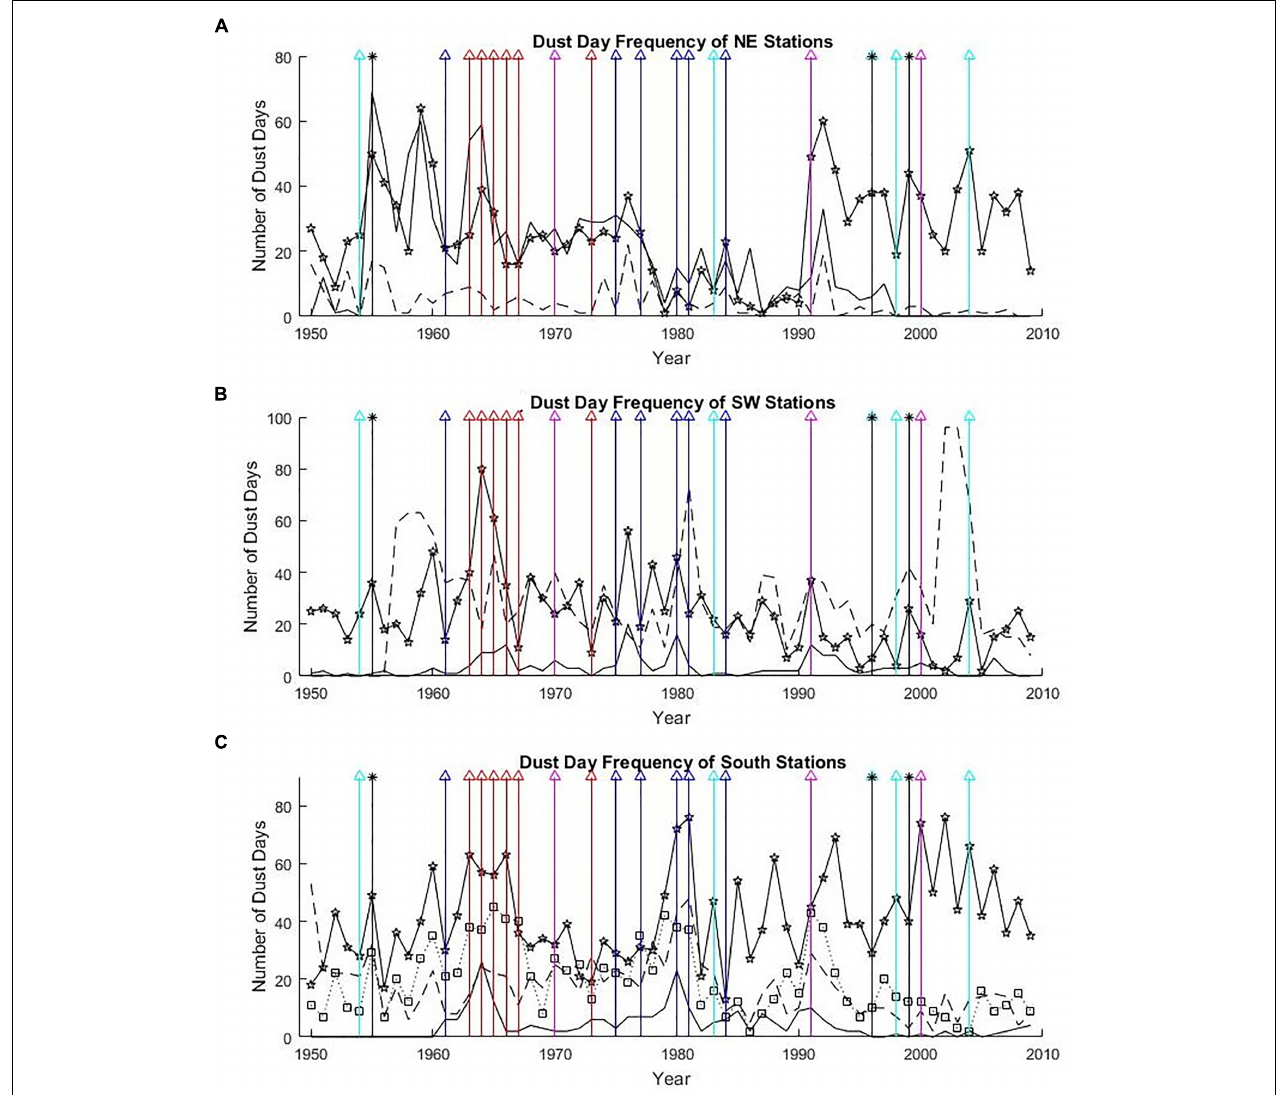
FIGURE 6 | The line graphs along the y -axis indicate the number of dust days each year, separated by region. (A) NE stations: Grímsstaðir ( ), Raufarhöfn ( – – –), Egilsstaðir ( —), (B) SW stations: Reykjavik ( ), Eyrarbakki ( – – –), Hæll ( —), (C) South stations: Stórhöfði ( ), Vatnsskarðshólar ( – – –), Vík í Mýrdal ( —), Kirkjubæjarklaustur ( (cid:3) dotted line). Volcanic eruptions ( (cid:52) ) and major jokulhlaups (black ∗ ) depicted with vertical lines. In southern Iceland, there are eruptions in Vestmannaeyjar (red (cid:52) ) and Hekla (magenta (cid:52) ); in NE Iceland, there are eruptions in Askja and Krafla (blue (cid:52) ) and Grimsvötn (cyan (cid:52) ). The jökulhlaup (black ∗ ) in 1996 occured at Grimsvötn Gjalp, while the other two lines (black ∗ ) indicate Mýrdalsjökulhlaups in the South.